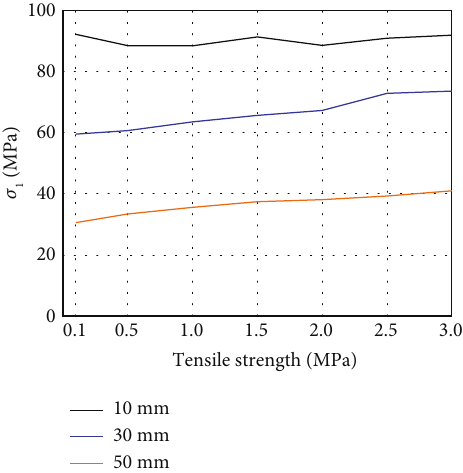
Figure 14: Uniaxial compressive strength of limestone grouting reinforcement bodies under di ff erent crack lengths and di ff erent bonding tensile strength values of grouting stone bodies.